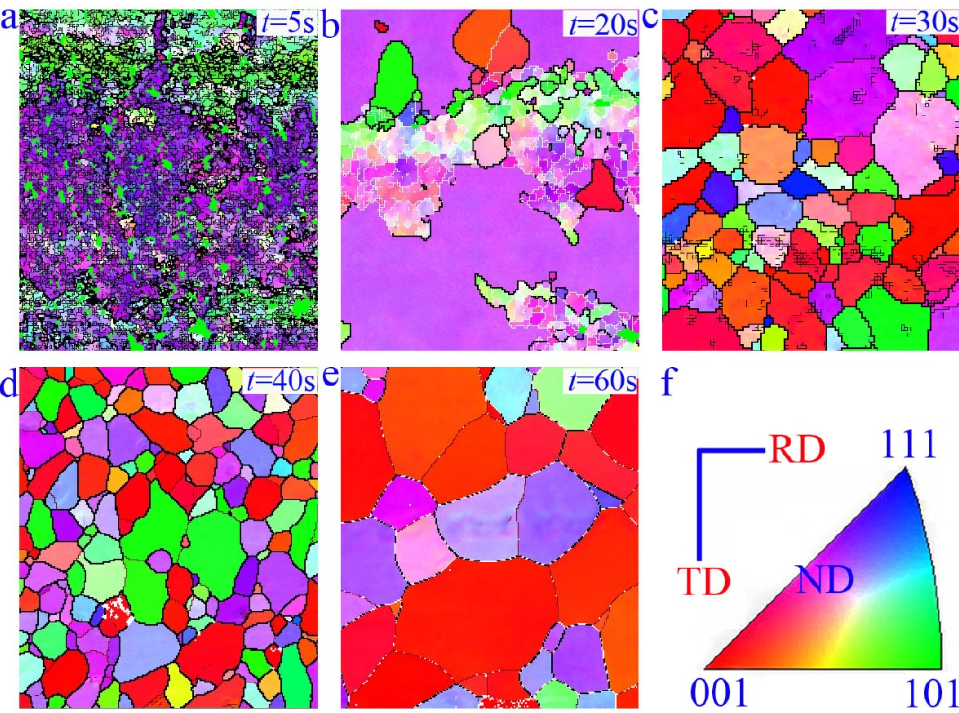
Figure 9. EBSD IPF maps of cold rolled CR-85% at 500 °C annealing for ( a ) 5 s; ( b ) 20 s; ( c ) 30 s; ( d ) 40 s; ( e ) 60 s; ( f ) color code.